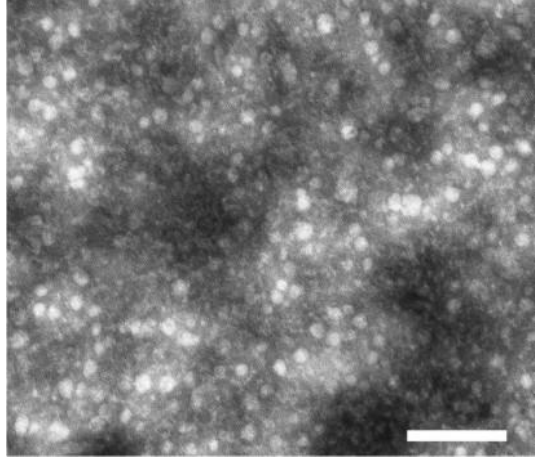
FIGURE 4. Negative-staining TEM of purified ultramicroforms of A.laidlawii PG8 after buoyant density-gradient centrifugation. Bar corresponds to 100